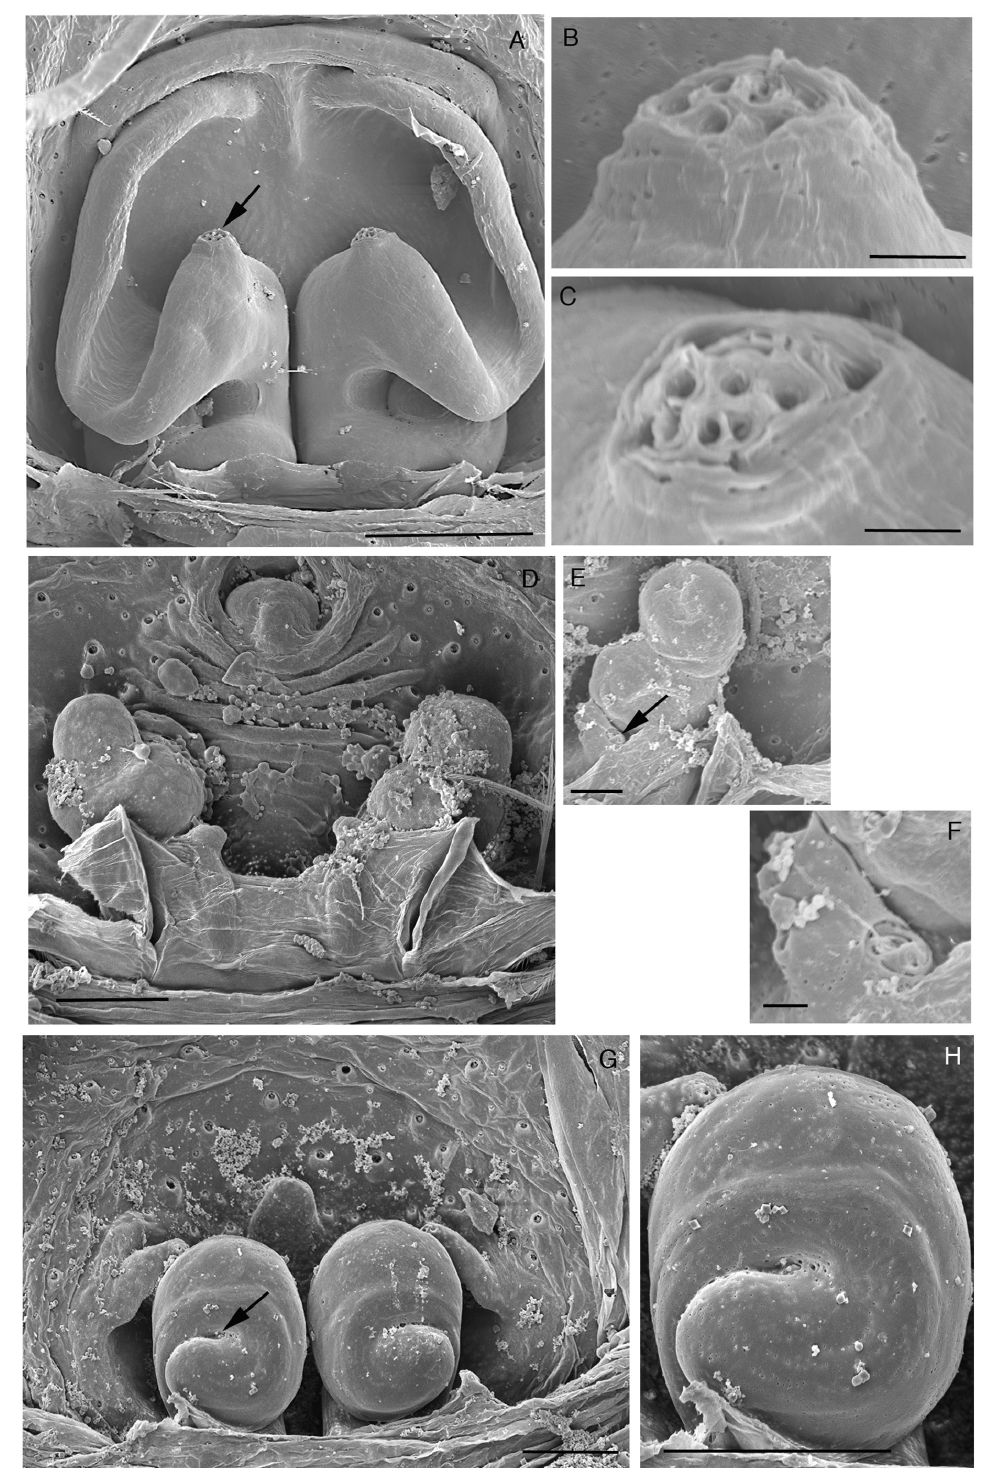
Fig. 8. SEM pictures of female genitalia. A-C. Cteniogaster conviva sp. nov. A. Dorsal view, arrow indicates perforations. B. Detail of previous. C. Idem, seen at different angle. D-F. Cteniogaster toxarchus gen. et sp. nov. D. Dorsal view. E. Detail of other specimen, arrow indicates perforations. F. Detail of previous. G-H. Cteniogaster hexomma sp. nov. G. Dorsal view, arrow indicates peforations. H. Detail of previous. Scale bars = A, D, G-H = 50 µm; B, C = 10 µm; E = 20 µm; F = 5